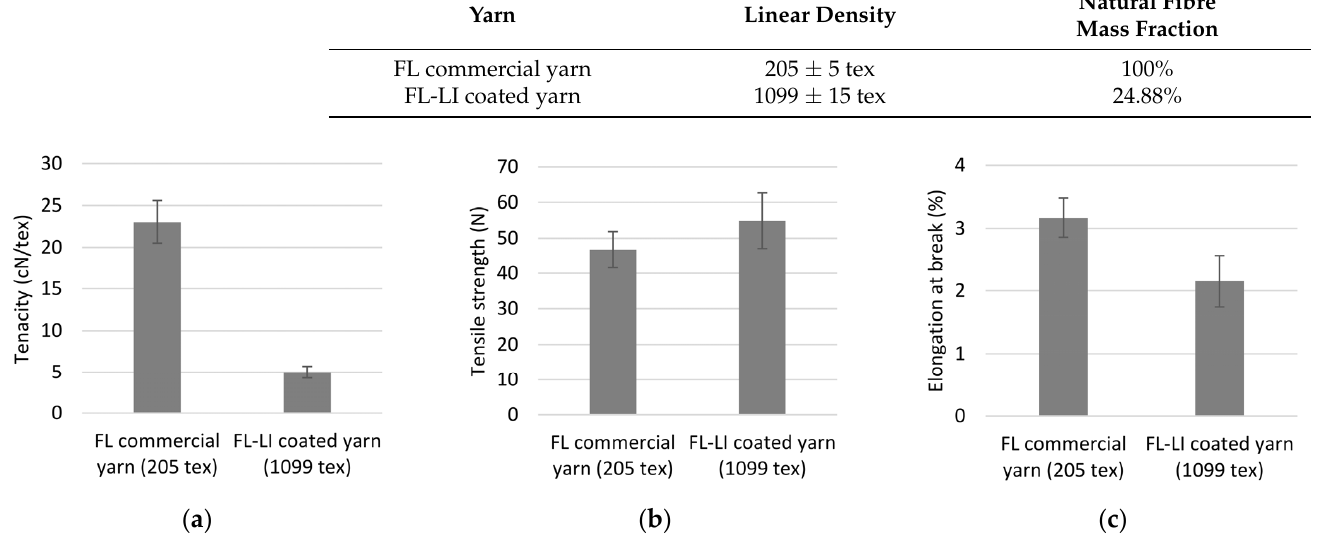
Table 6. Linear density and fibre mass fraction of yarns. Yarn